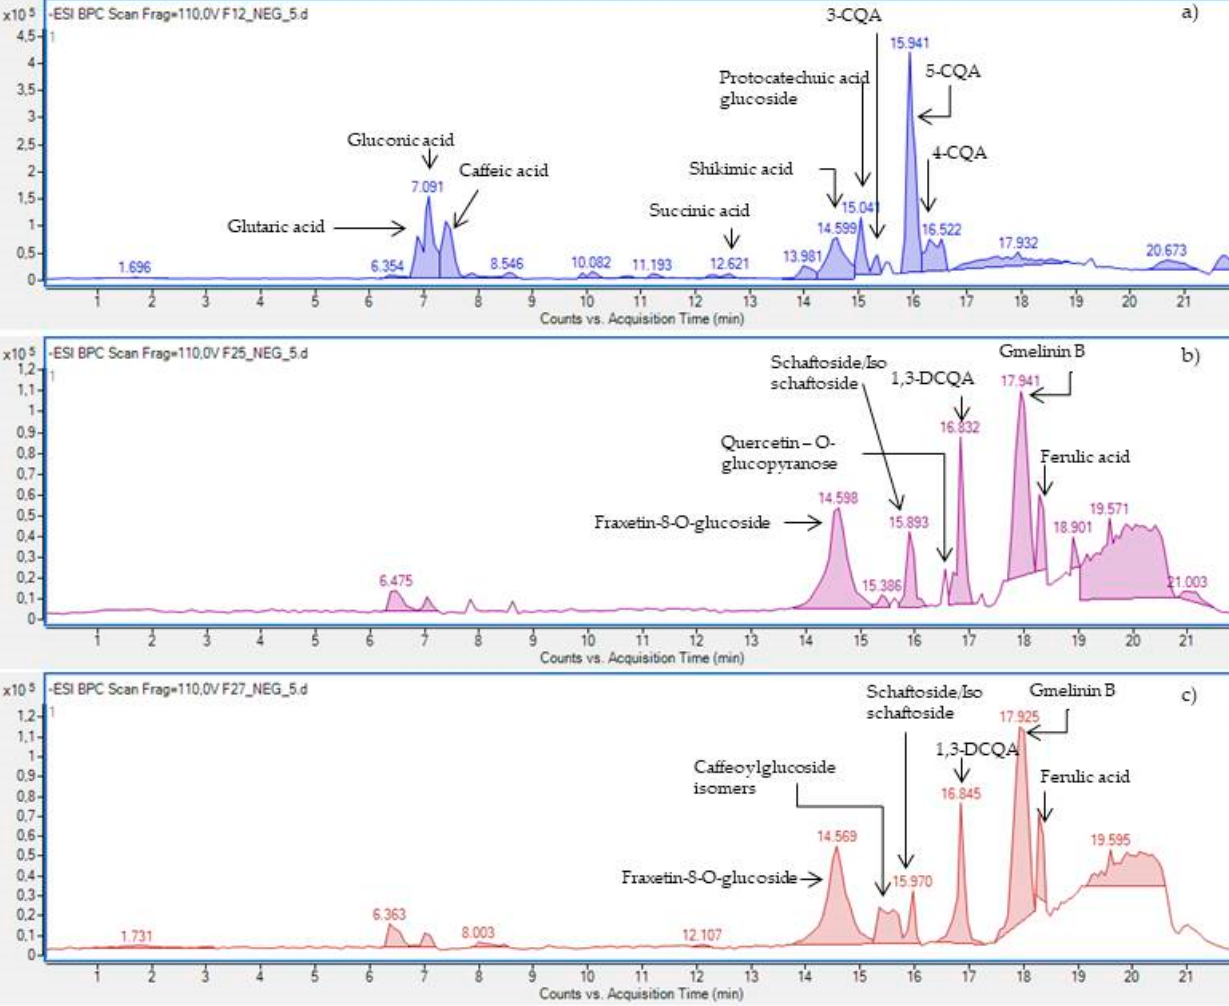
Figure 6. The TIC chromatogram recorded in the negative ionization modes for the Achillea biebersteinii fractions: 12 ( a ), 25 ( b ), and 27 ( c ).